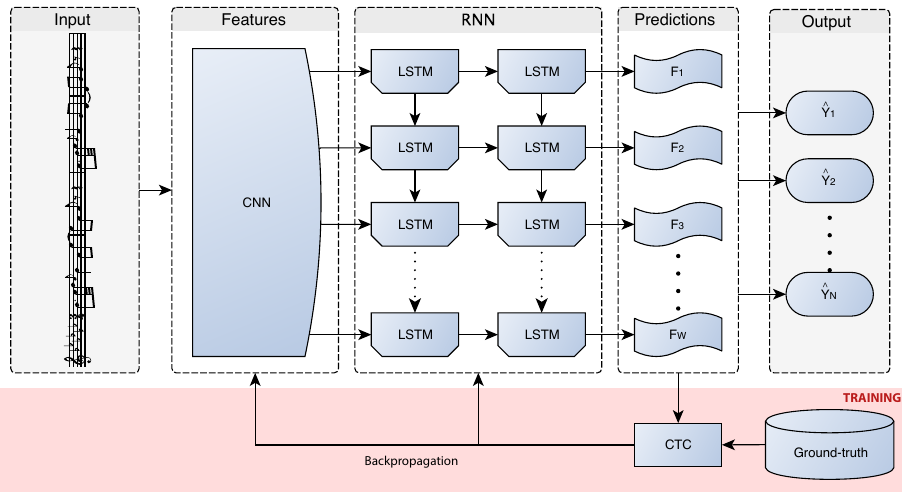
Figure 4. Graphical scheme of the end-to-end neural approach